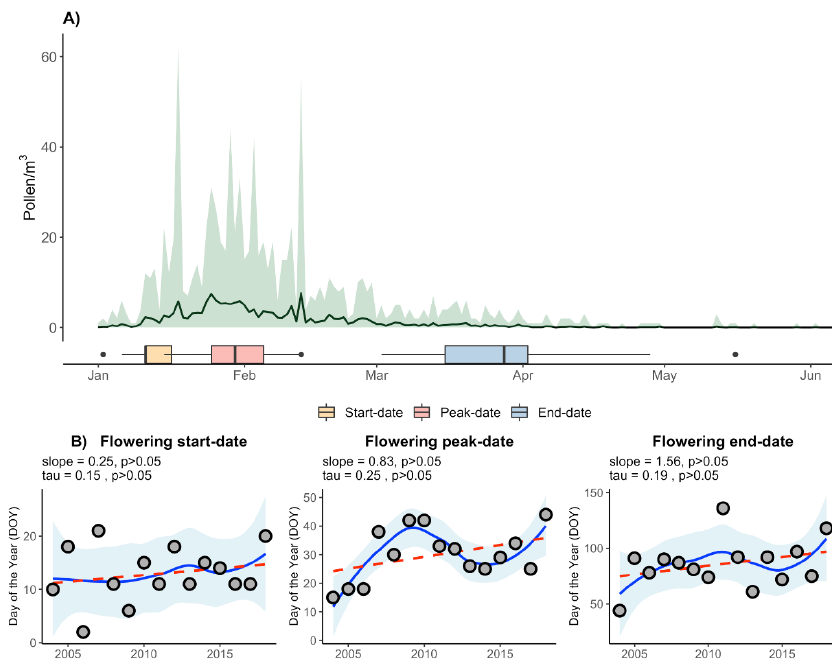
Figure 4. Amplitude (maximum and minimum) and mean values of the daily airborne pollen concentrations for the period 2004-2018. A, phenological graph of alder pollen; B, temporal trends of the main pollen season phenophases of alder (start, peak, and end-dates) for the period 2004–2018 using linear regressions (slope) and Mann-Kendall tests (tau). Table 1. Results of the Spearman correlation test among the start-date of the flowering of alder tree and average temperatures of the